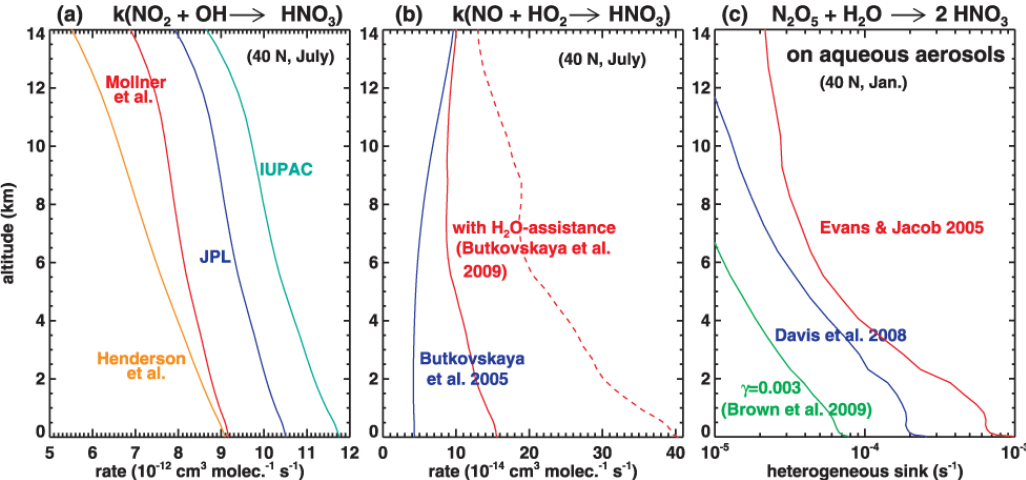
Fig. 1. Zonally averaged vertical profiles at 40 ◦ N of (a) the NO 2 + OH reaction rate in July, (b) the NO + HO 2 → HNO 3 reaction rate in July, and (c) the heterogeneous sink of N 2 O 5 on aqueous aerosols over continents in January. The continuous red line in panel (b) assumes that the NO-reaction rate of the HO 2 · H 2 O complex ( k w ) is constant, whereas the dashed red line uses the temperature and pressure dependence of the rate in dry conditions ( k d